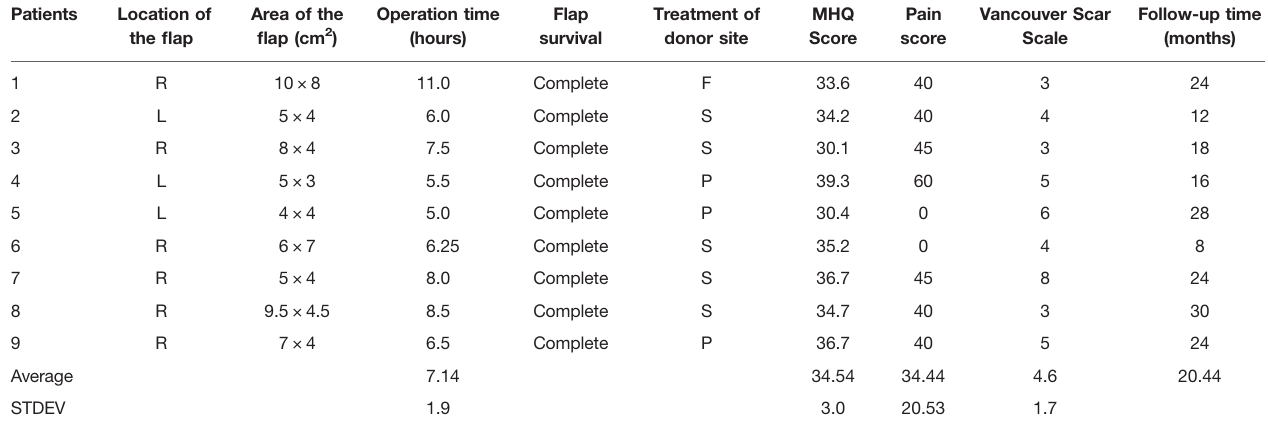
TABLE 2 | Surgical outcomes.